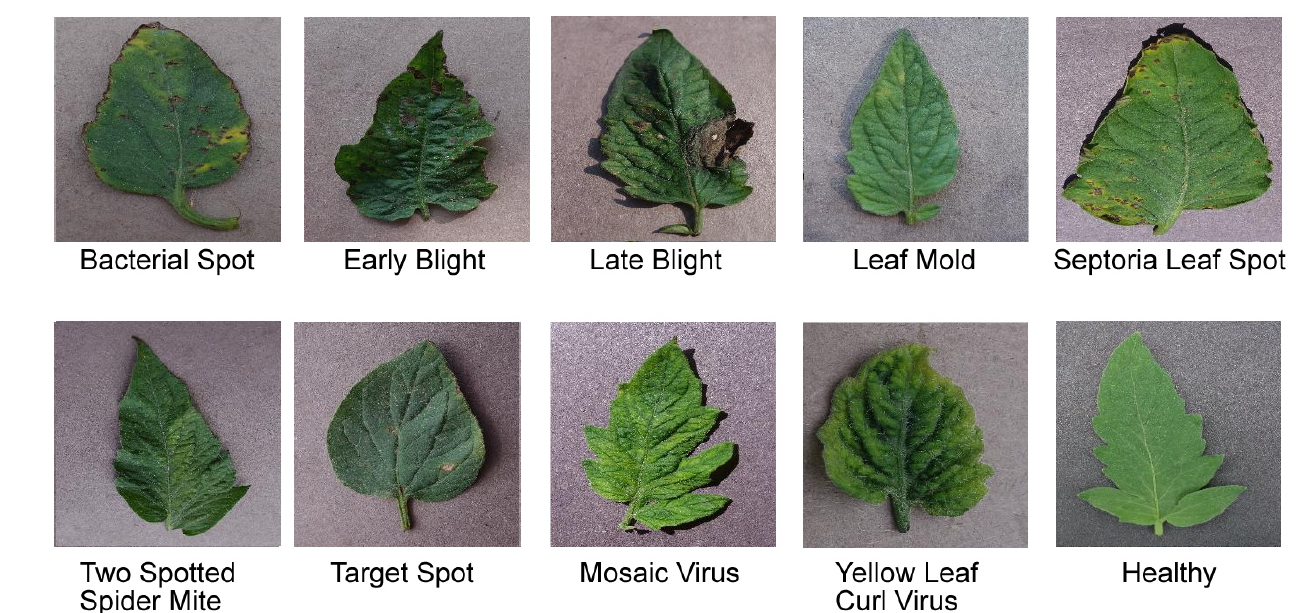
Figure 1. Sample images of the tomato plant from the PlantVillage collection (nine diseases and one healthy).